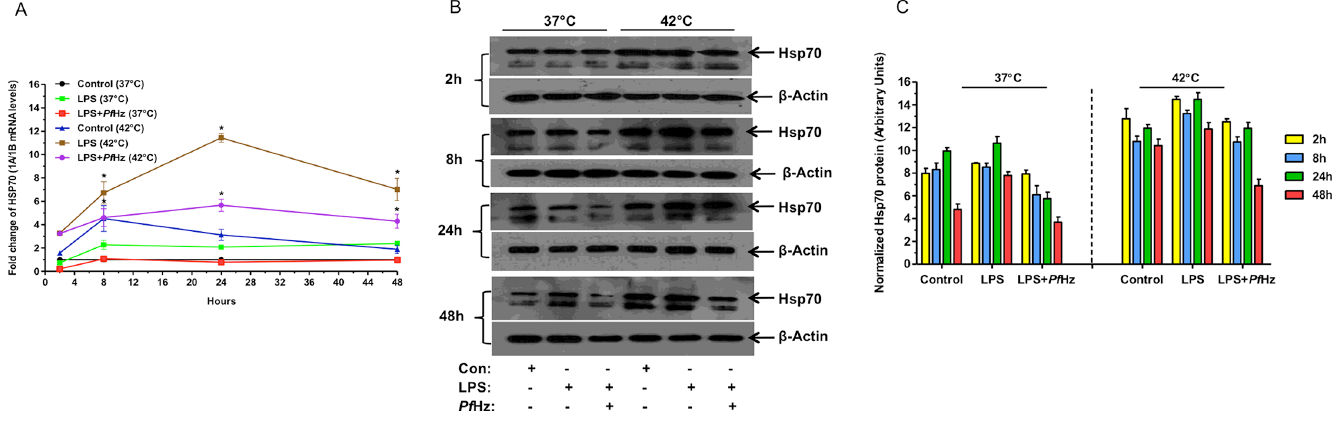
Figure 3. Effect of Pf Hz on HSP70 expression. Peripheral blood mononuclear cells (2.5 × 10 6 ) were incubated for 2 h at either 37°C (phys- iological) or 42°C (heat shock treatment) and stimulated with LPS for 1 h. Cells were then treated with Pf Hz (10 μ g/mL) and incubated for different time points (2 to 48 h). (A) Total RNA was isolated and gene expression analysis by qRT-PCR was performed to quantify the HSP70 ( 1A + 1B ) transcripts, using TaqMan ® gene expression assays. β -actin was used as an endogenous control to normalize the data by the ΔΔ CT method. Data represent average of individuals (n = 3) with each condition performed in triplicate (error bars represent SEM). * indicates P < 0.05 (one-way ANOVA) relative to control conditions at the given temperature. (B) Cell lysates were prepared after har- vesting cells from identical experiments at the stipulated time points, and equal amounts of protein were loaded on 4-20% SDS-PAGE to determine the Hsp70 protein levels by immunoblotting. (C) Densitometry analysis was performed to quantify intensity of production (n = 3); error bars represent SEM. Data shown after normalizing Hsp70 relative to β